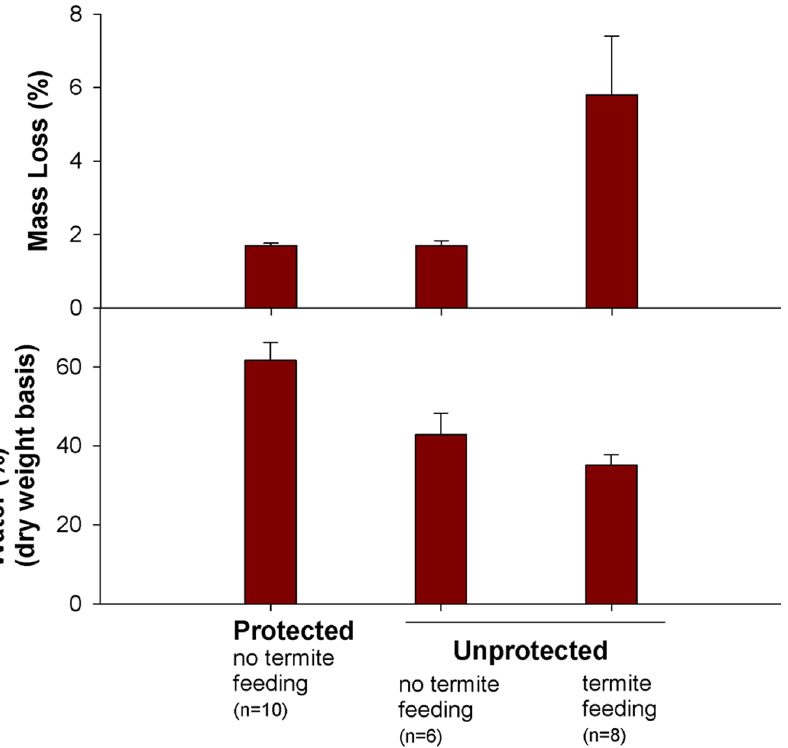
Figure 6. Mass loss and water content of protected and unprotected blocks after 20-weeks. Protected blocks were enclosed within stainless steel mesh for the duration of the experiment. doi:10.1371/journal.pone.0101867.g006 PLOS ONE |